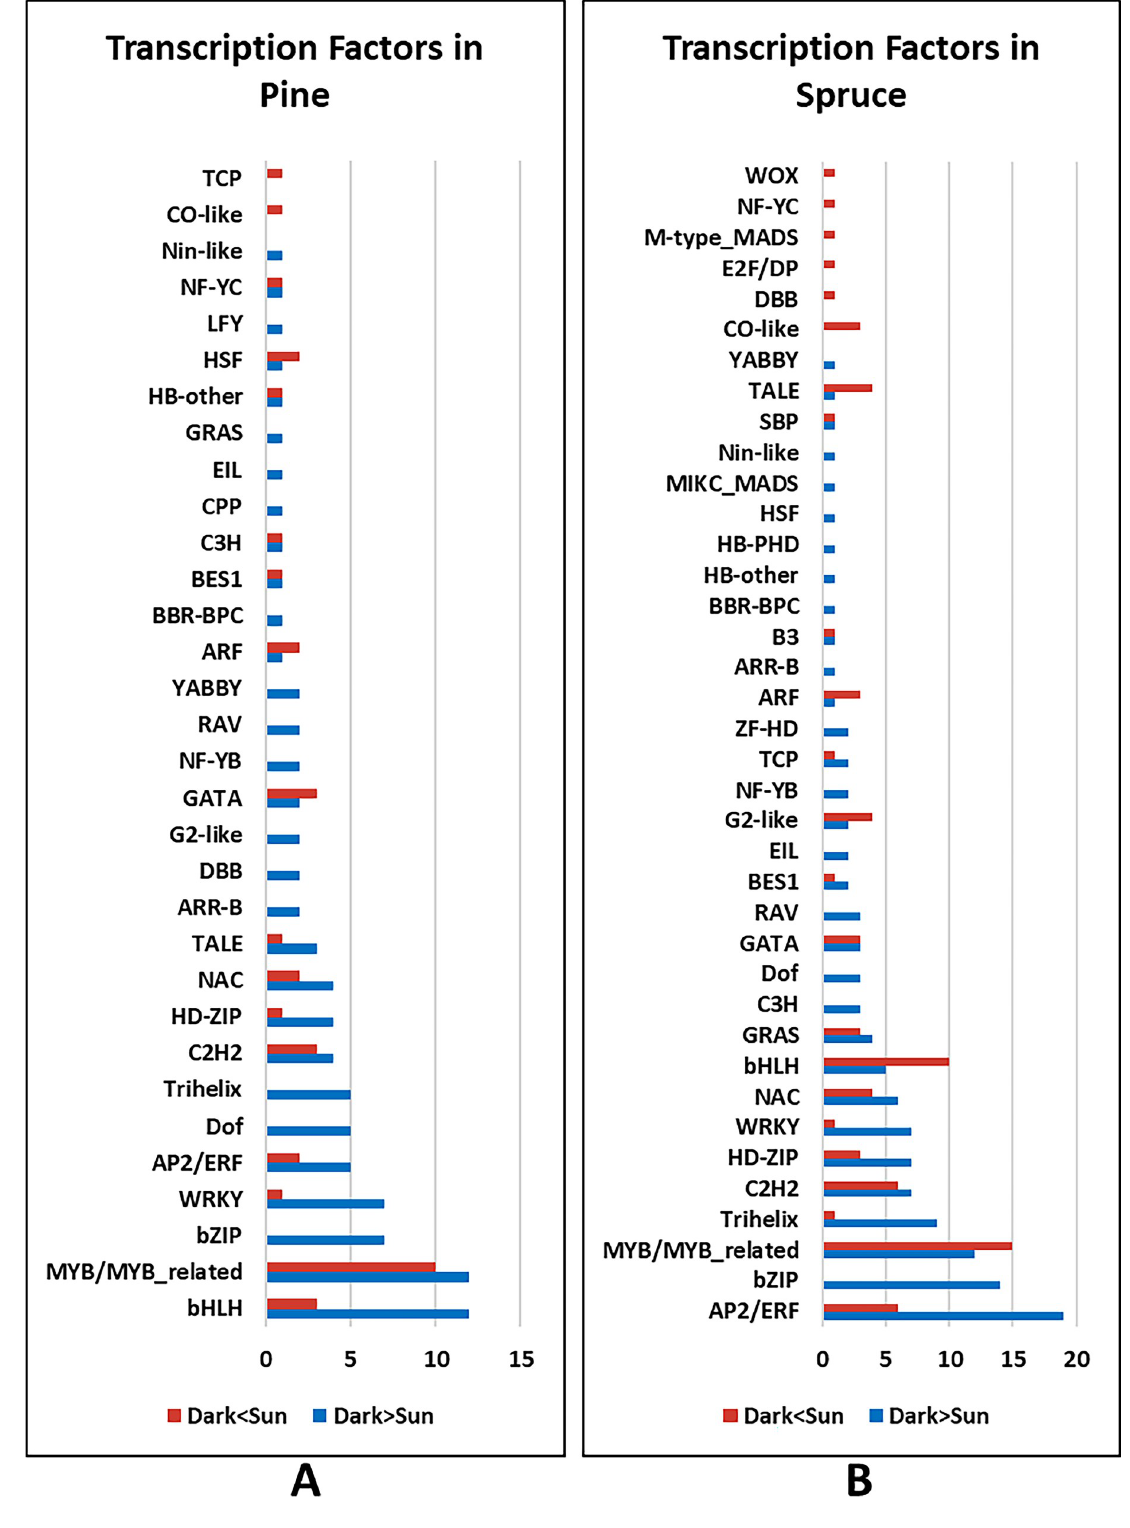
Fig 4. Transcription factors involved in etiolation and de-etiolation. (A) Scots pine and (B) Norway spruce.